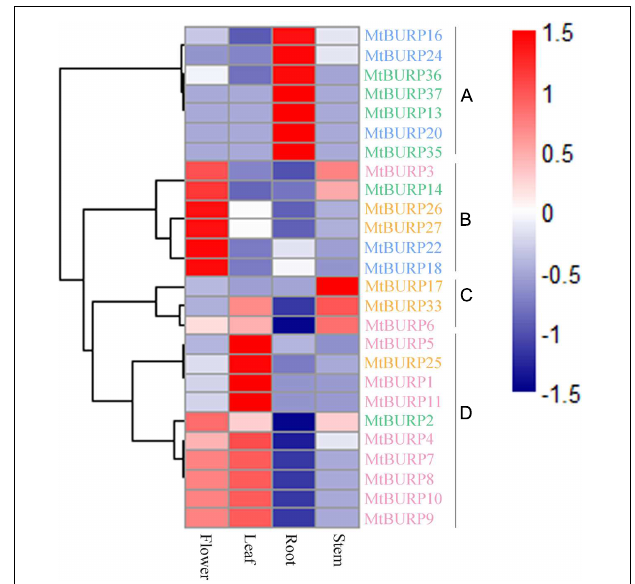
FIGURE 8 | Hierarchical clustering of MtBURP proteins in four tissues of Medicago truncatula. RNA-seq relative expression data from 4 tissues were used to reconstruct the expression patterns of Medicago genes. The raw data was normalized and retrieved from the online database (http://mtgea.noble.org/v2/). Gene names in different subfamilies are highlighted with various colors. Genes clustered into four groups (A–D) are indicated by the black vertical